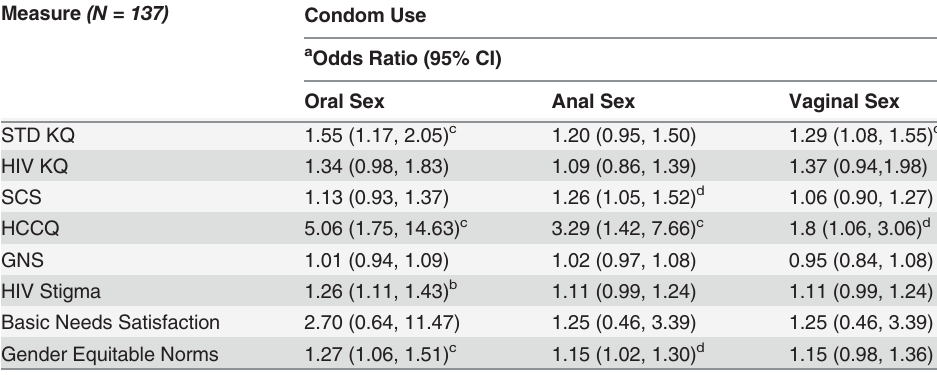
Table 7. Generalized estimating equation assessing associations between social and psychological variables and condom use. Condom Use